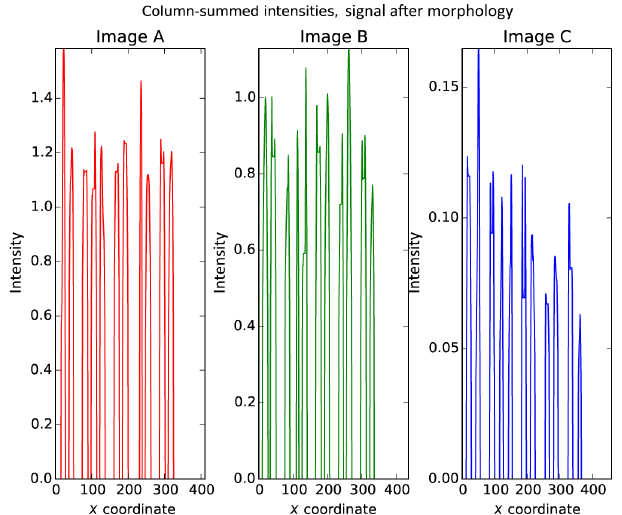
Figure 12. The column-summed intensities of images A, B and C (Figs. 4, 5 and 6) after applying a closing operator.